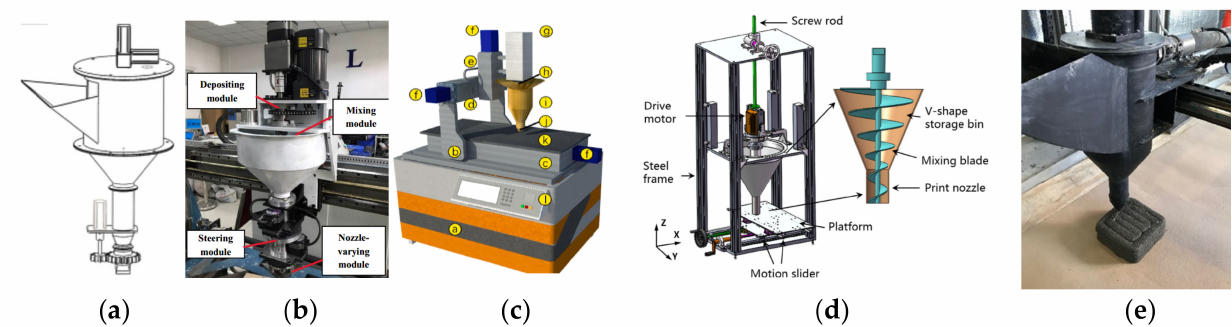
Figure 7. Local feeders in the existing studies, reprinted with permissions: ( a ) a V-shape sketch design material bin with a feeding open and a turn-able nozzle tip [29], ( b ) a material bin with a size-varying nozzle tip [73], ( c ) a desktop printer with a V-shape material bin [75], ( d ) a printing system with a V-shape storage bin and a mixing blade [80], and ( e ) a printing nozzle with a local feeder